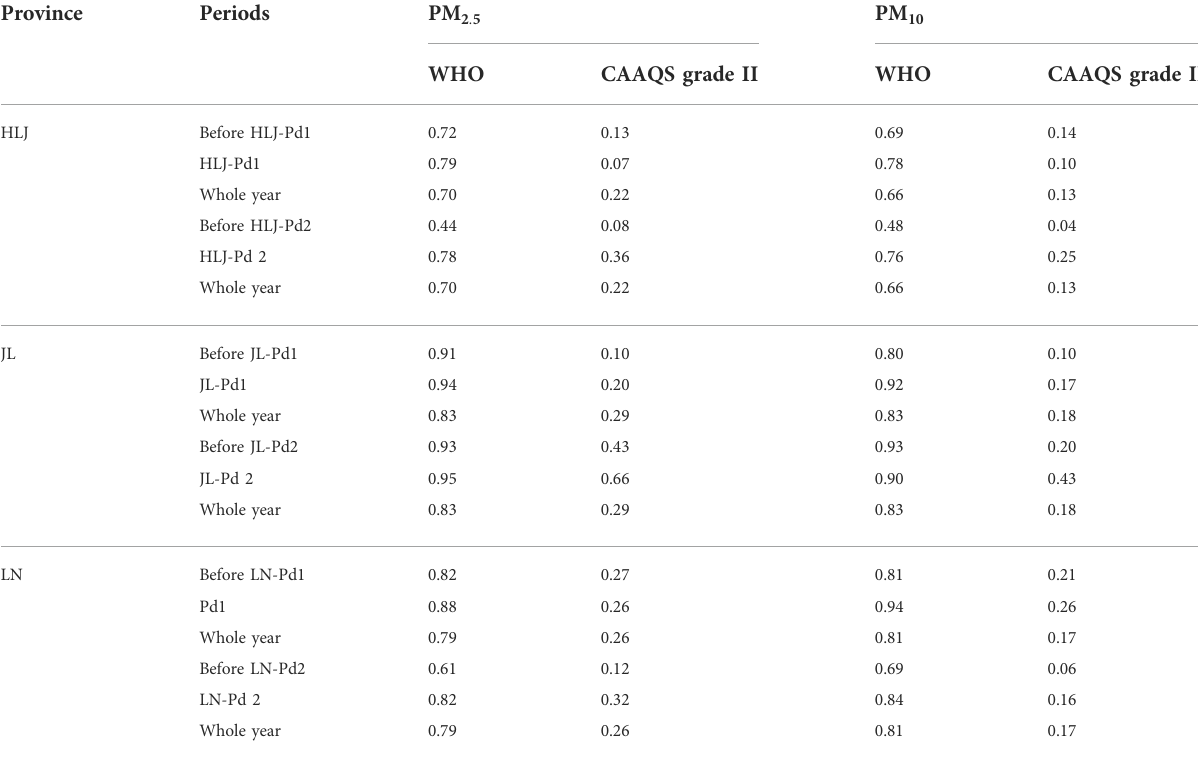
TABLE 2 Ratio of stations exceeding health risk limitations in different periods in